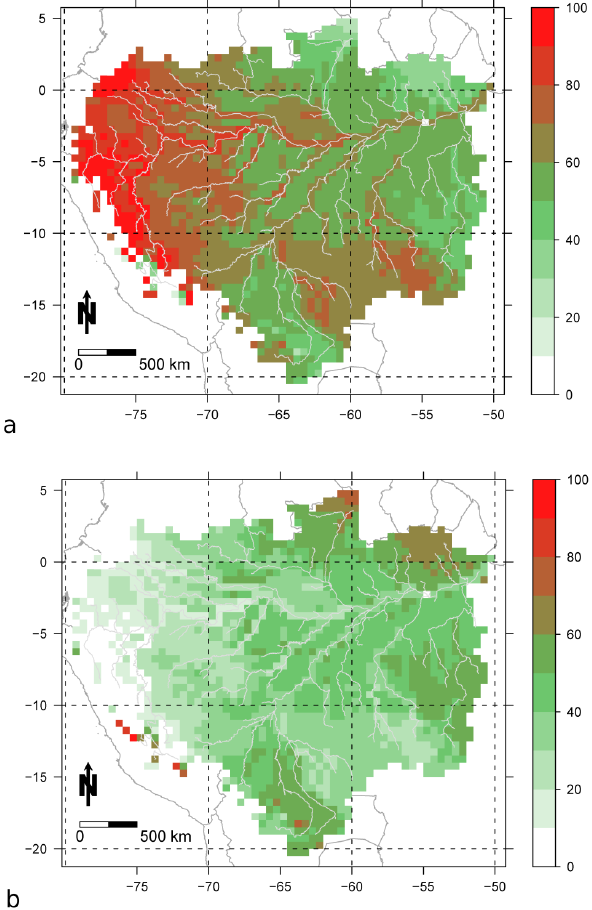
Fig. 6. Proportion of models in agreement [%] in (a) an increase and Figure 6. Proportion of models in agreement [%] in (a) an increase and (b) a decrease 843 (b) a decrease of mean annual inundated area per cell. The propor- tion represents the agreement between the 24 model runs showing of mean annual inundated area per cell. The proportion represents the agreement 844 an increase or a decrease in inundated area, respectively. between the 24 model runs showing an increase or a decrease in inundated area, 845 respectively. 846